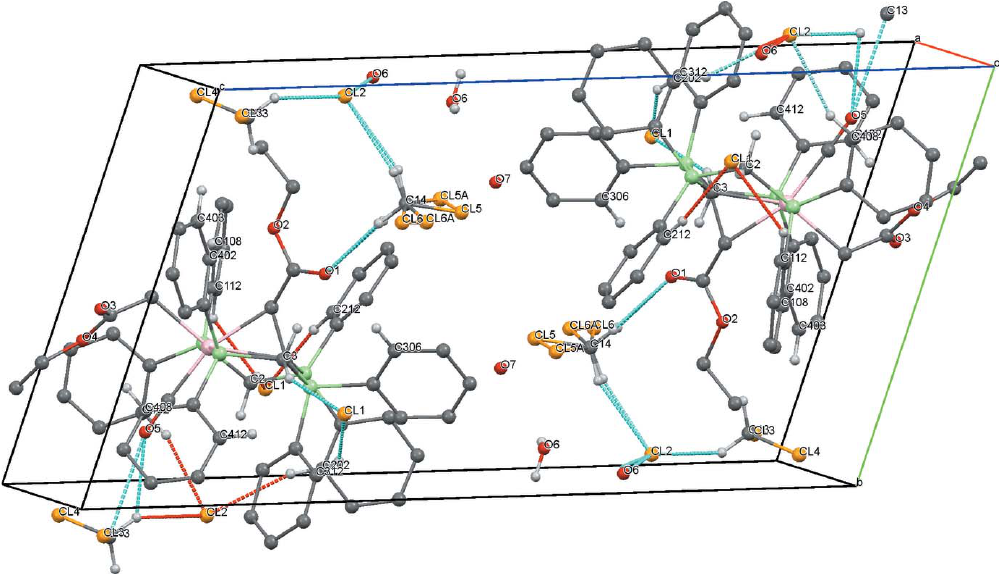
Figure 9 Aview along the a axis of the crystal packing of compound 7 . Only the H atoms involved in the most significant intermolecular interactions (Table 5) are presented and the intramolecular interactions are omitted. The solvent molecules are